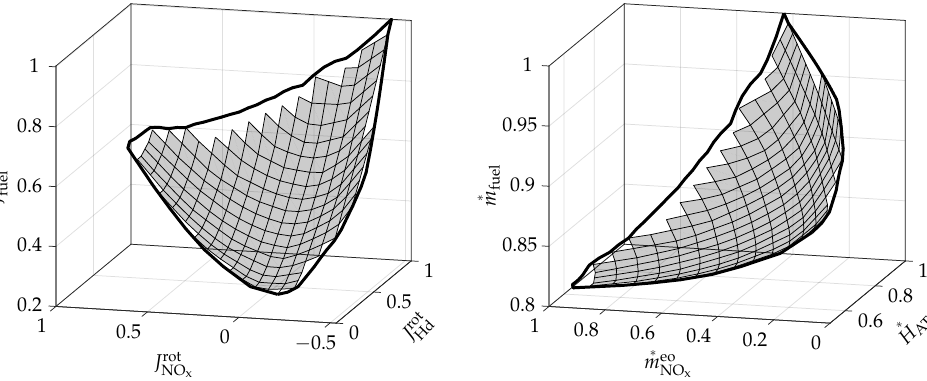
Figure 6. Exemplary Pareto front at an engine speed of 2000 rpm, an engine torque of 200Nm, and an ATS temperature of 340K. The image on the left shows the fitted Pareto front described by scaled and rotated values. The image on the right shows the fitted Pareto front transferred back to physically meaningful values. The values in the plot on the right were